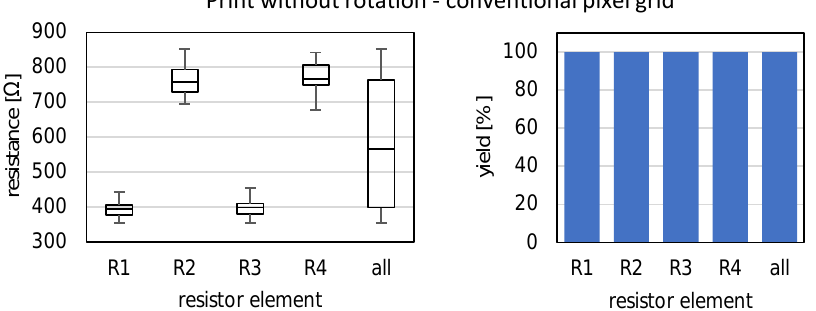
Figure 11. Electrical properties of SG full bridges, conventional print without rotation. Left : Resistances of the resistance elements, right : Yield of intact resistance elements.